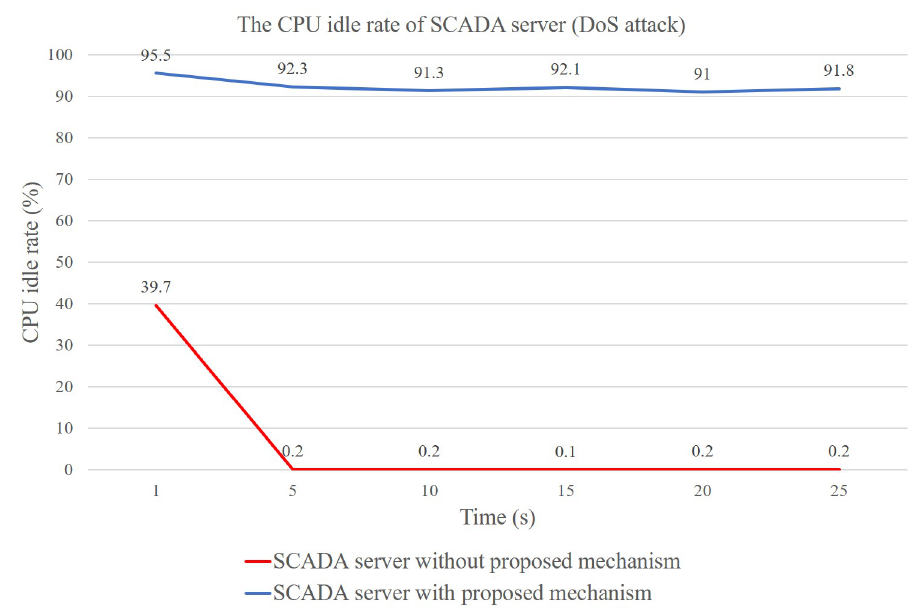
Figure 12. Performance comparison with DoS